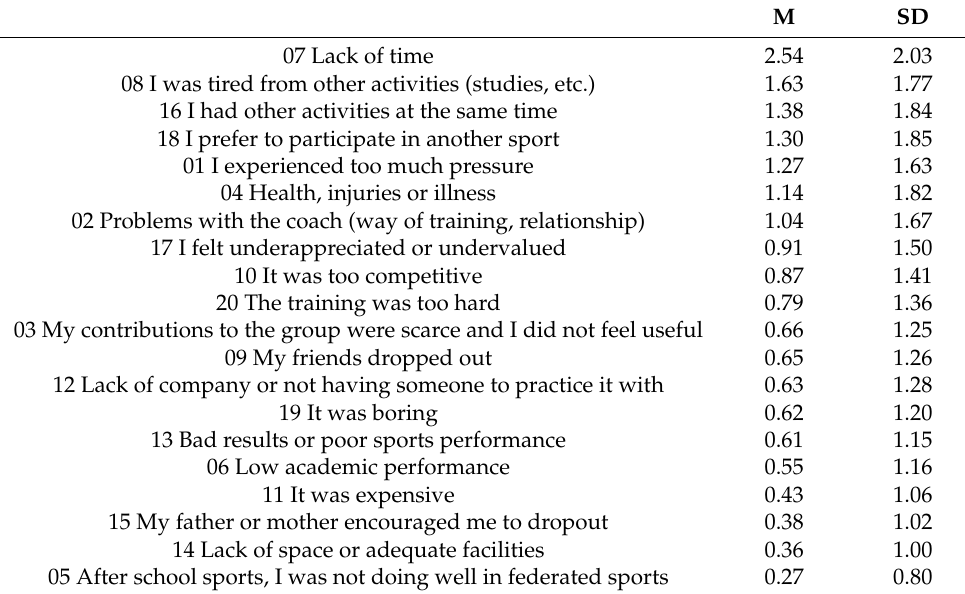
Table 1. Means and standard deviations of the dropout